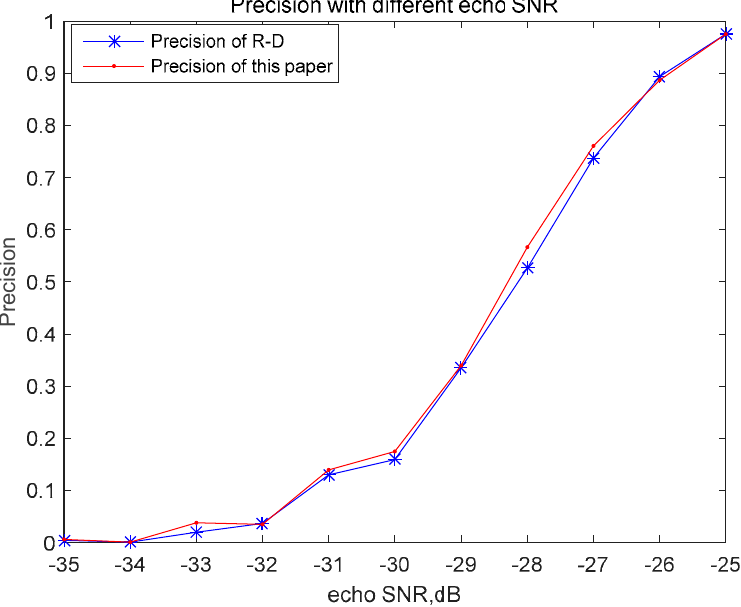
Figure 11. Precision of target detection with different noise power values ( N = 10 4 ): reference SNR = 0 dB.